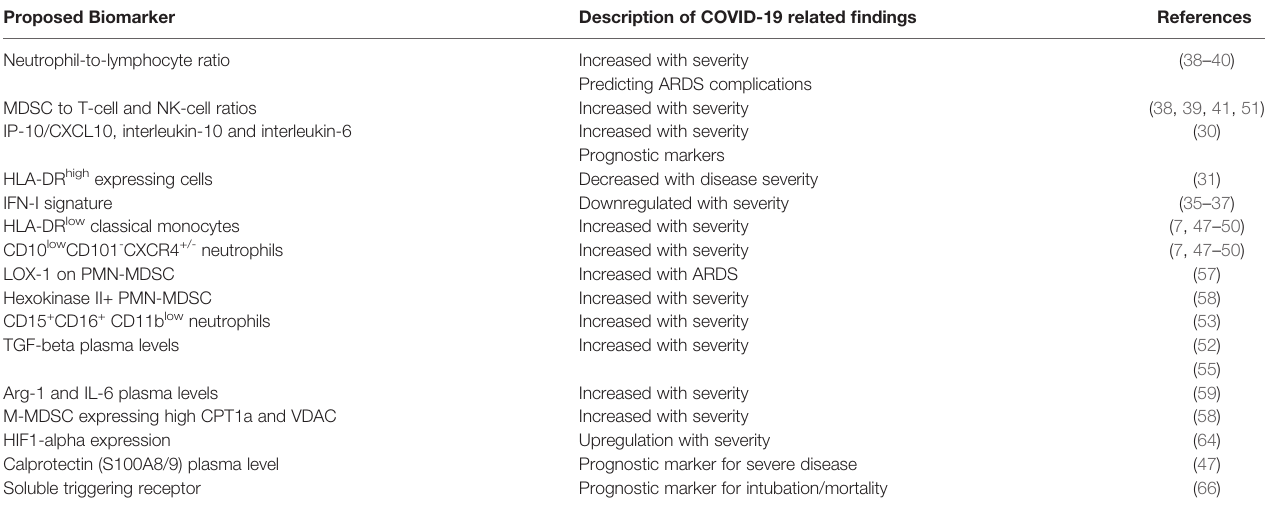
TABLE 2 | Candidate myeloid biomarkers associated with COVID-19 disease